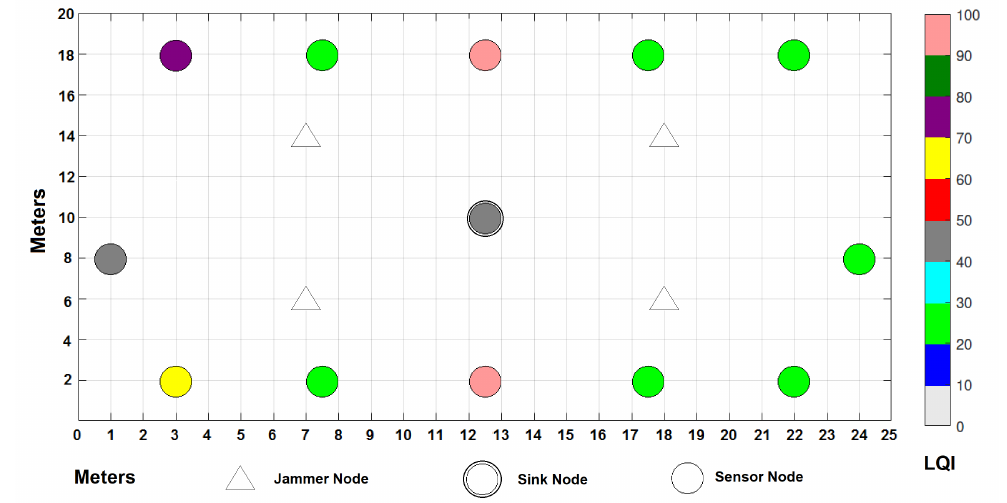
Figure 17. LQI results per node under a collaborative